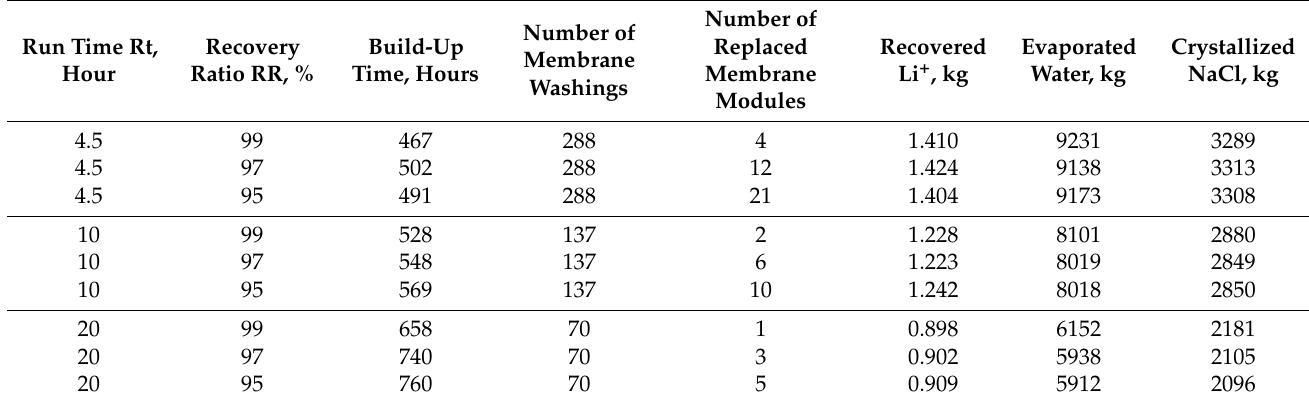
Table 5. Effect of run time RT and recovery ratio RR on process parameters (two months of operation). Simulation